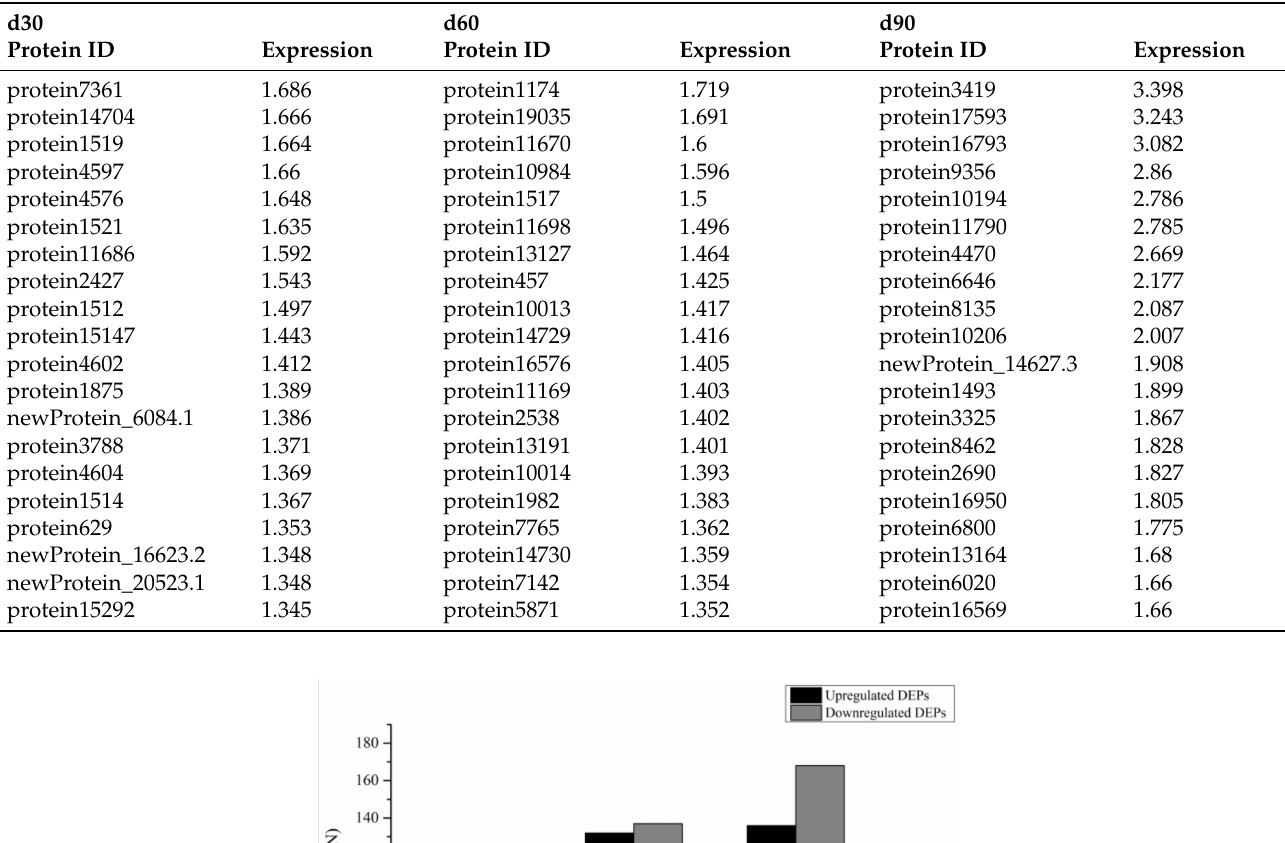
Table 2. Top proteins with highest expression in three libraries.